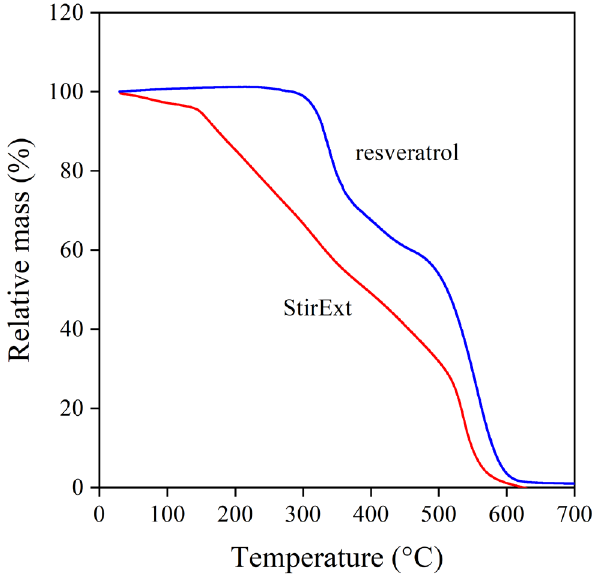
Figure 3. Thermogravimetric analysis of trans -resveratrol and grape peel extract produced in the stirred tank reactor.